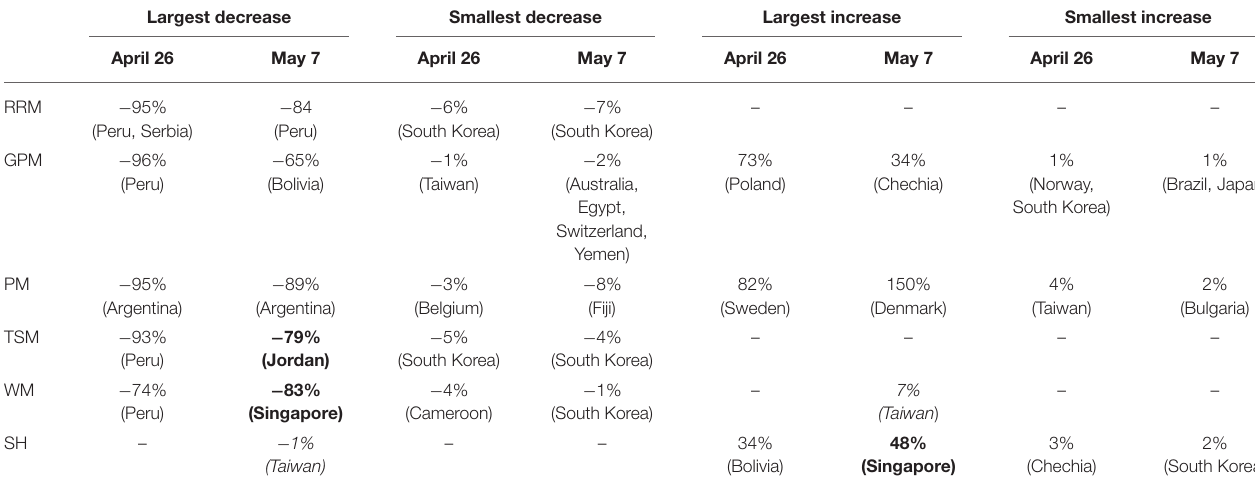
TABLE 1 | Largest and smallest percentage increases and decreases for mobility.